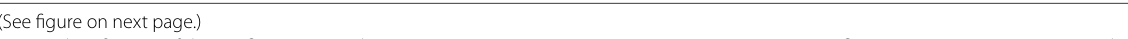
3) for 200 genes in 509 samples. D Heatmap of 200 =